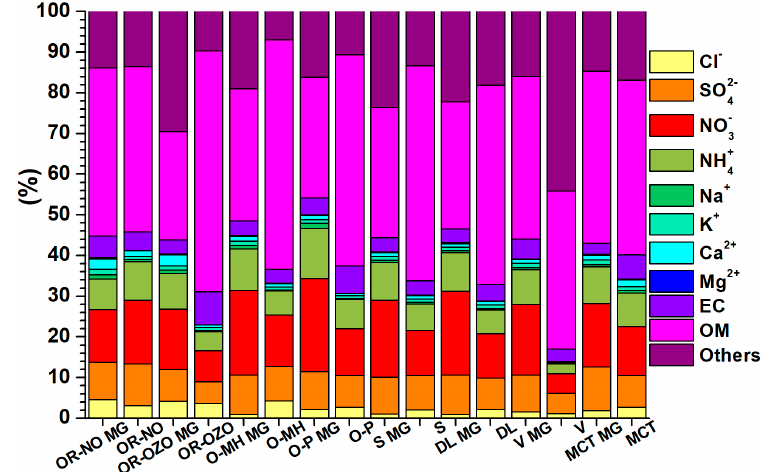
Figure 9. The composition of PM 10 during di ff erent air flowing (MG—Moravian Gate) for all measurements, AVG—average.